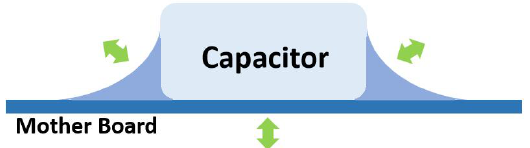
Figure 7. Capacitor exhibits inverse piezoelectric effect due to electric field.